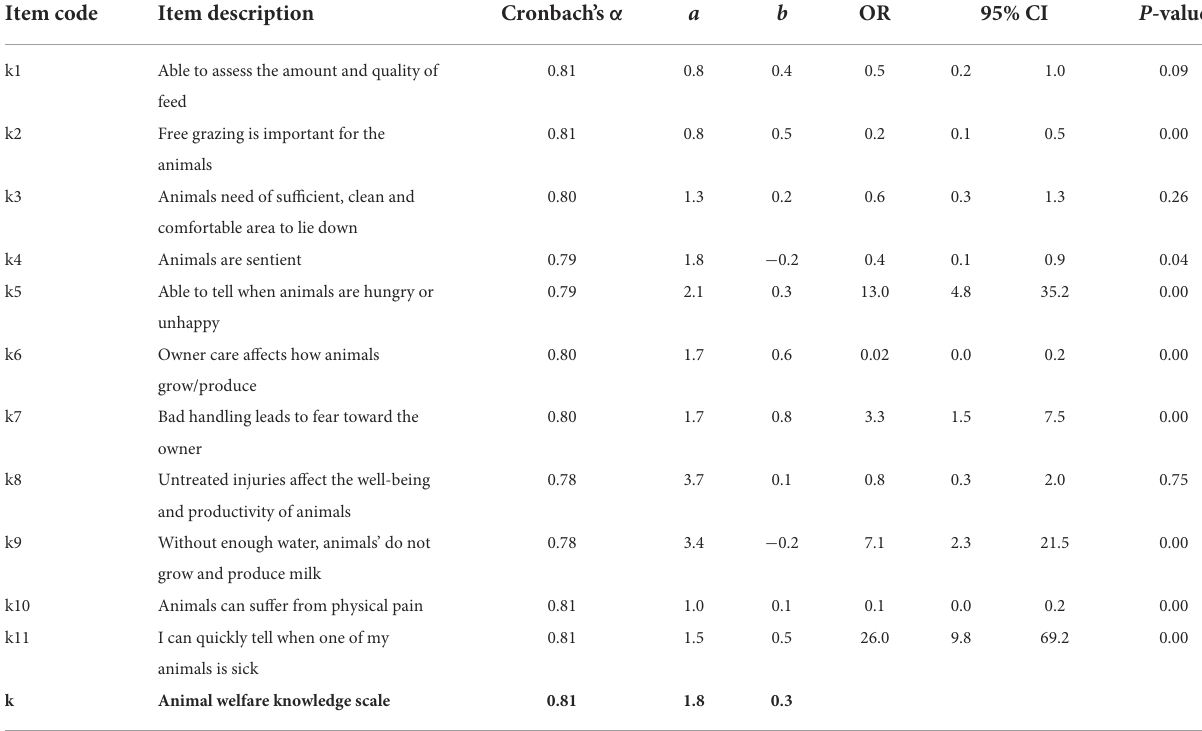
TABLE 4 Cronbach’s alpha, IRT parameter estimates and uniform DIF for the animal welfare knowledge